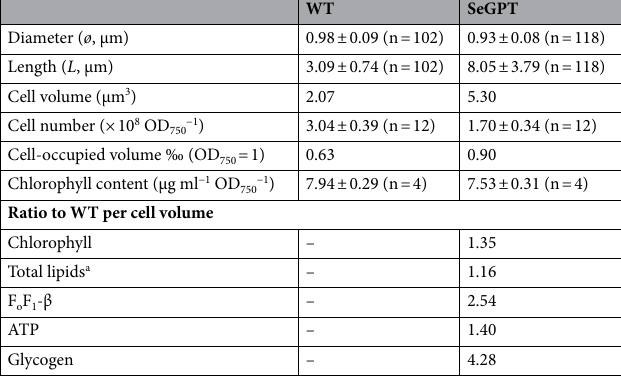
Table 1. Estimation of cell volume and evaluation of cellular compounds per cell-occupied volume. a Data for total lipid content are based on Apdila et al. 24